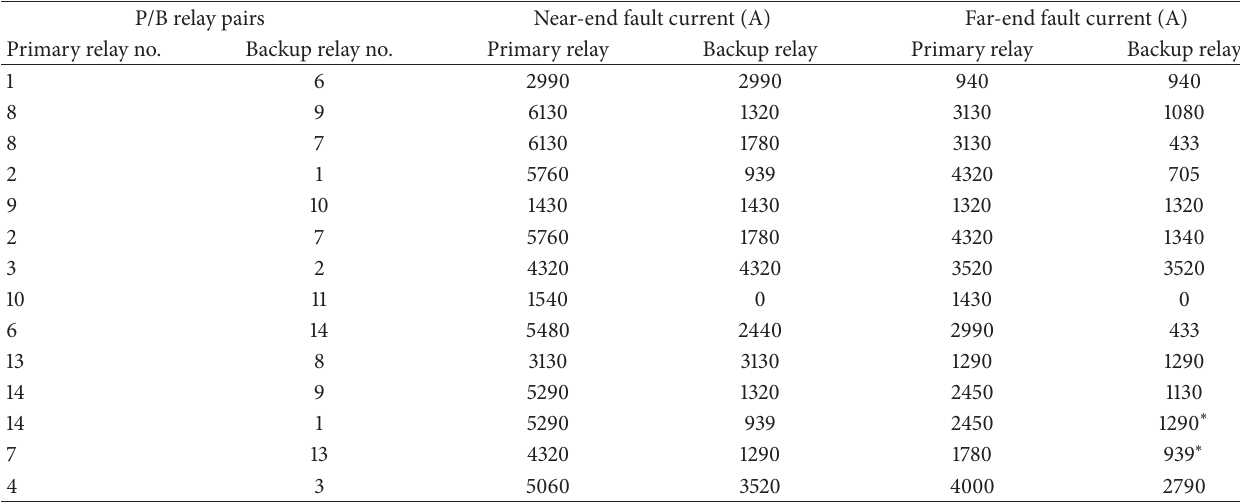
Table 4: Primary/backup relay pairs and the fault currents after the removal of Line